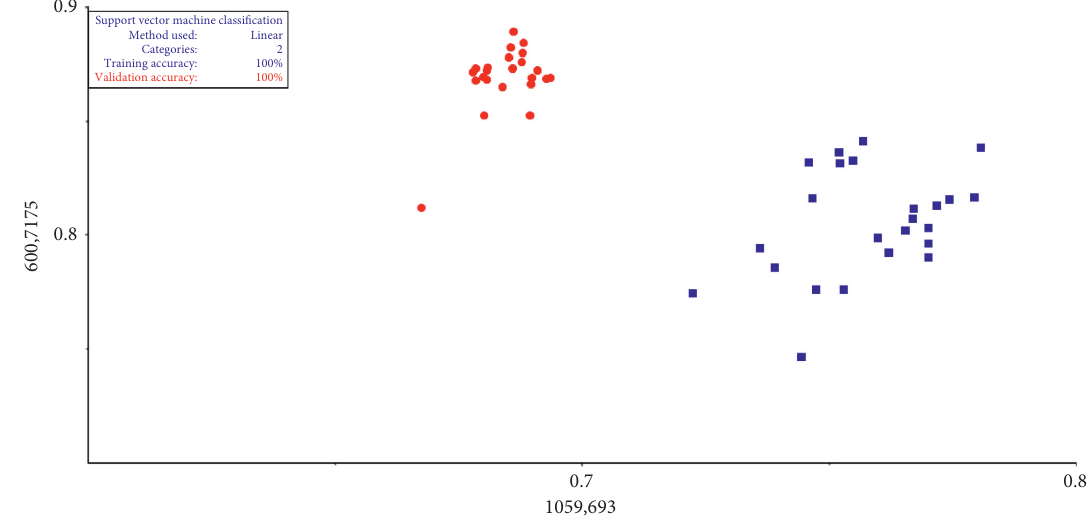
Figure 4: Classification by support vector machine (SVM) using linear kernel